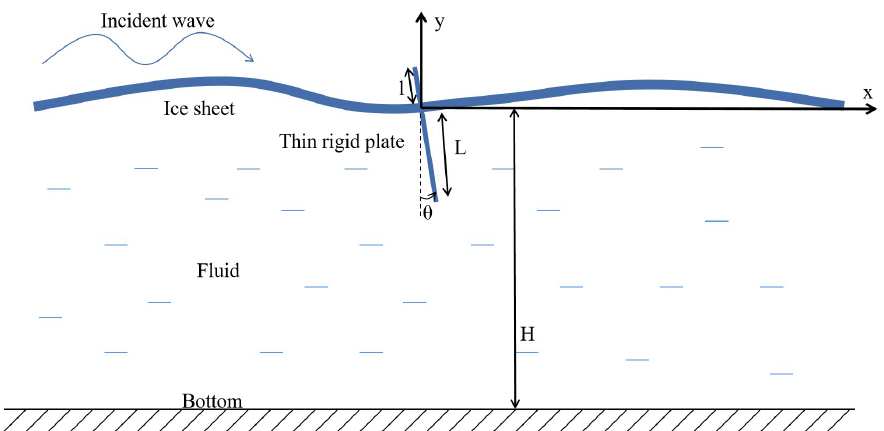
Figure 1. Sketch of wave propagating in an ice sheet with a rigid